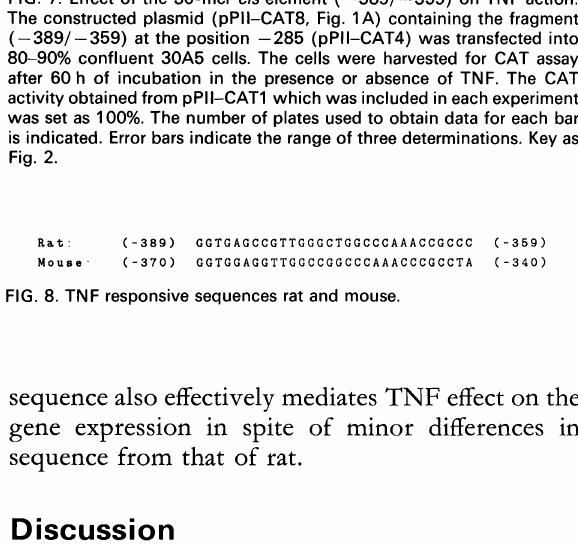
FIG. 9. Effect of the mouse TNF responsive region on expression of ACC-CAT construct. Two mouse constructs, pPI I-CAT4 mTN F No. 3 and No. 22, were transfected into 80% confluent 30A5 preadipocytes together with pPII-CAT2 and pPII-CAT4. Sixty hours later, CAT activities in cell lysates were assayed. The CAT activity of pPII-CAT1 included in this experiment was taken as 100%. Error bars indicate the range of three determinations. Key as Fig.